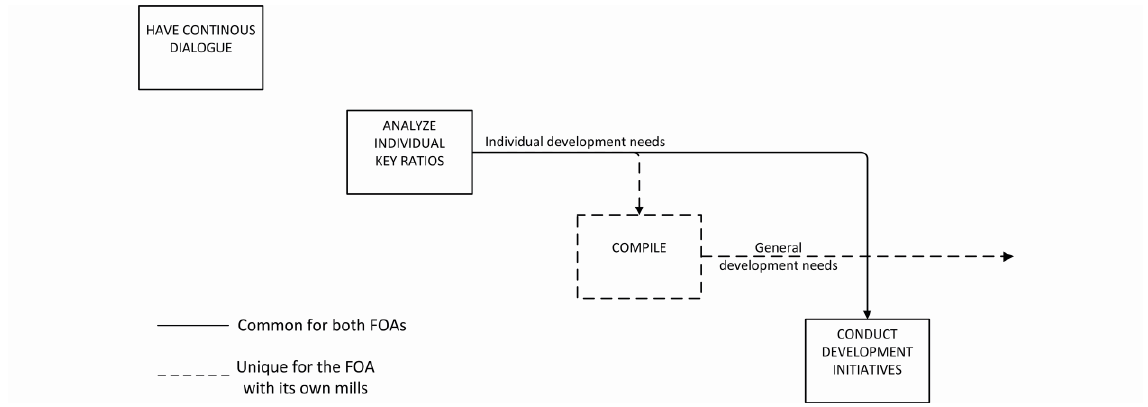
Figure 10. Sub-activities within the Develop activity. The dashed activity and information flows occurred only in the FOA with its own